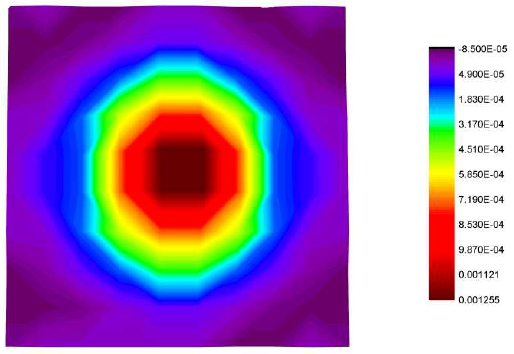
Figure 4. Displacement amplitude distribution of the plate on loading (P ) of 5.7N.